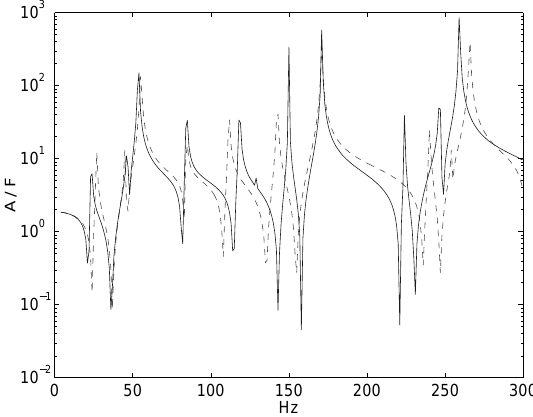
Fig. 2. Frame-plate coupling. Translation/force FRFs: complete FE model (–); coupling procedure (- - -) using experimental data.